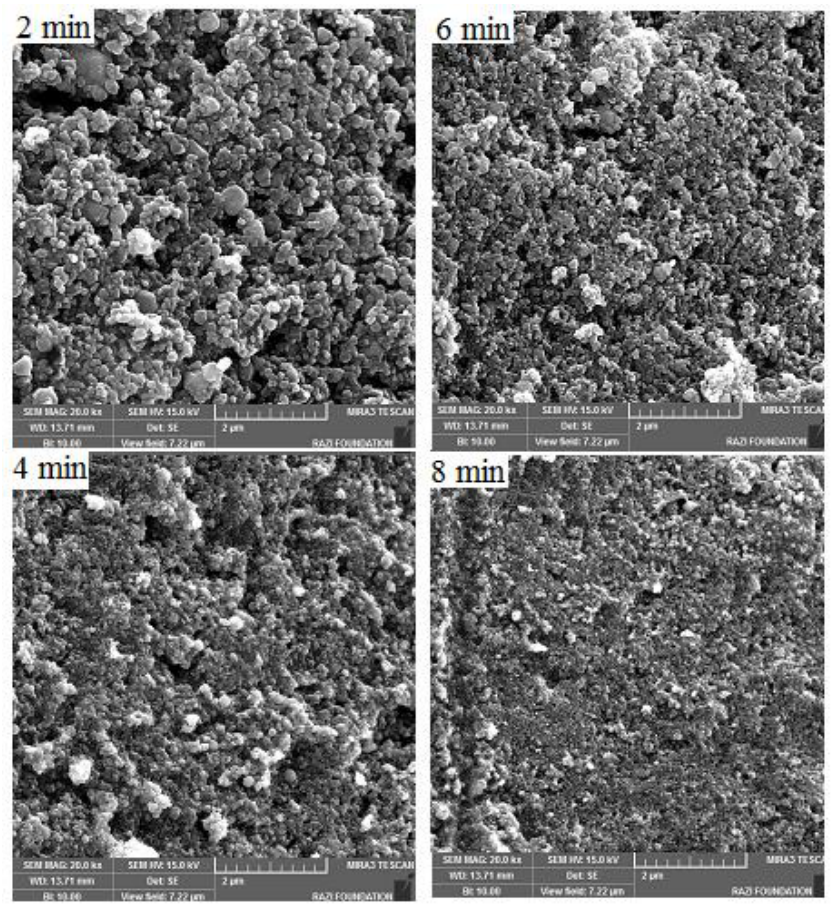
Fig. 2. SEM micrographs of SiC coating on c-c composite in different times of coating.